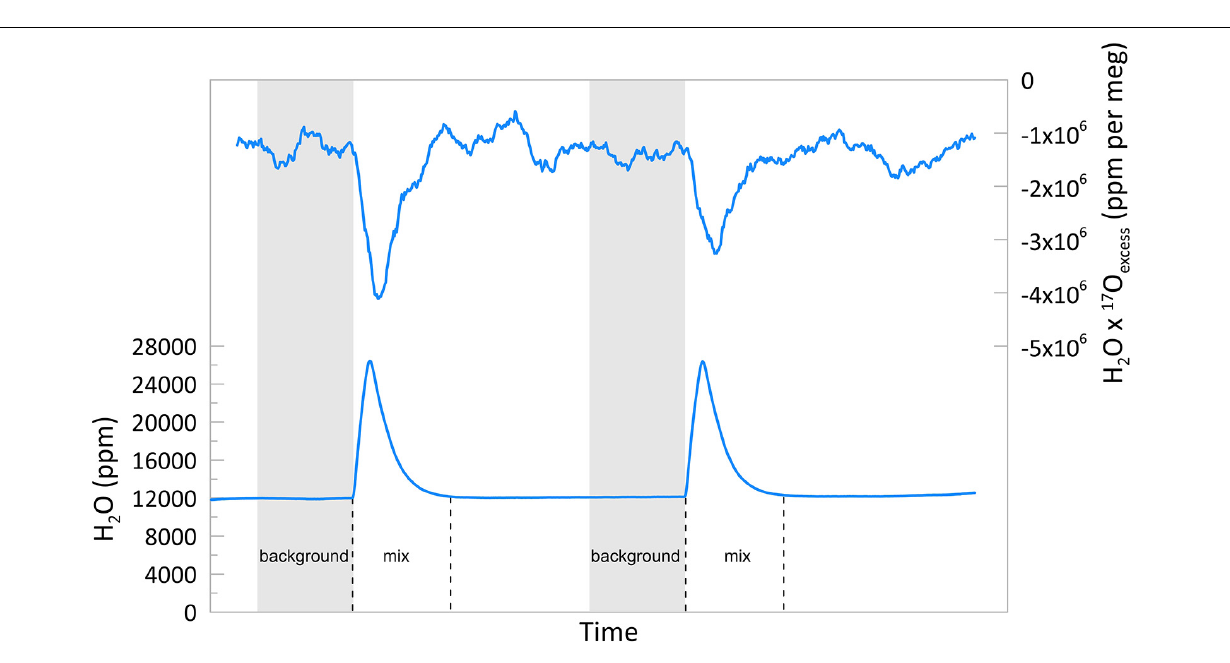
FIGURE 2 | Examples of 17 O excess measurement for two stalagmite samples and corresponding H 2 O peaks. Final 17 O excess values are calculated from the integration of 17 O excess and H 2 O over time (upper panel). Values of H 2 O × 17 O excess are averaged over 5 min in order to amplify the signal illustrated. 17 O excess “mix” represents the mixture of sample and background waters